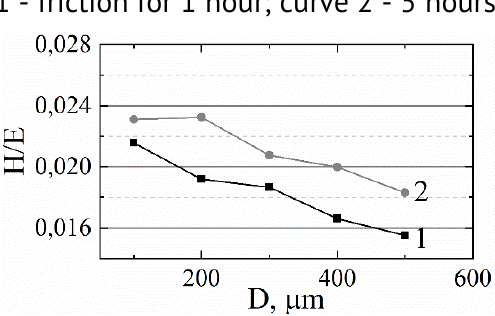
Figure 10. Change in Young's modulus ( E ) with distance ( D ) increasing to the “metal/metal” friction surface. Curve 1 - friction for 1 hour; curve 2 - 10 hours.